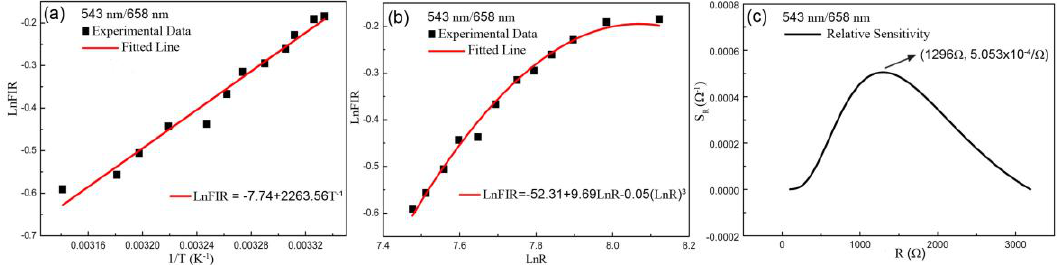
Figure 6. Plots of the ratio of 543 nm/658 nm including ( a ) the fitted curve of temperature-dependent FIR based on Boltzmann distribution law, ( b ) the fitted curve of resistance dependent FIR , ( c ) the relative sensitivity S R as a function of resistance.